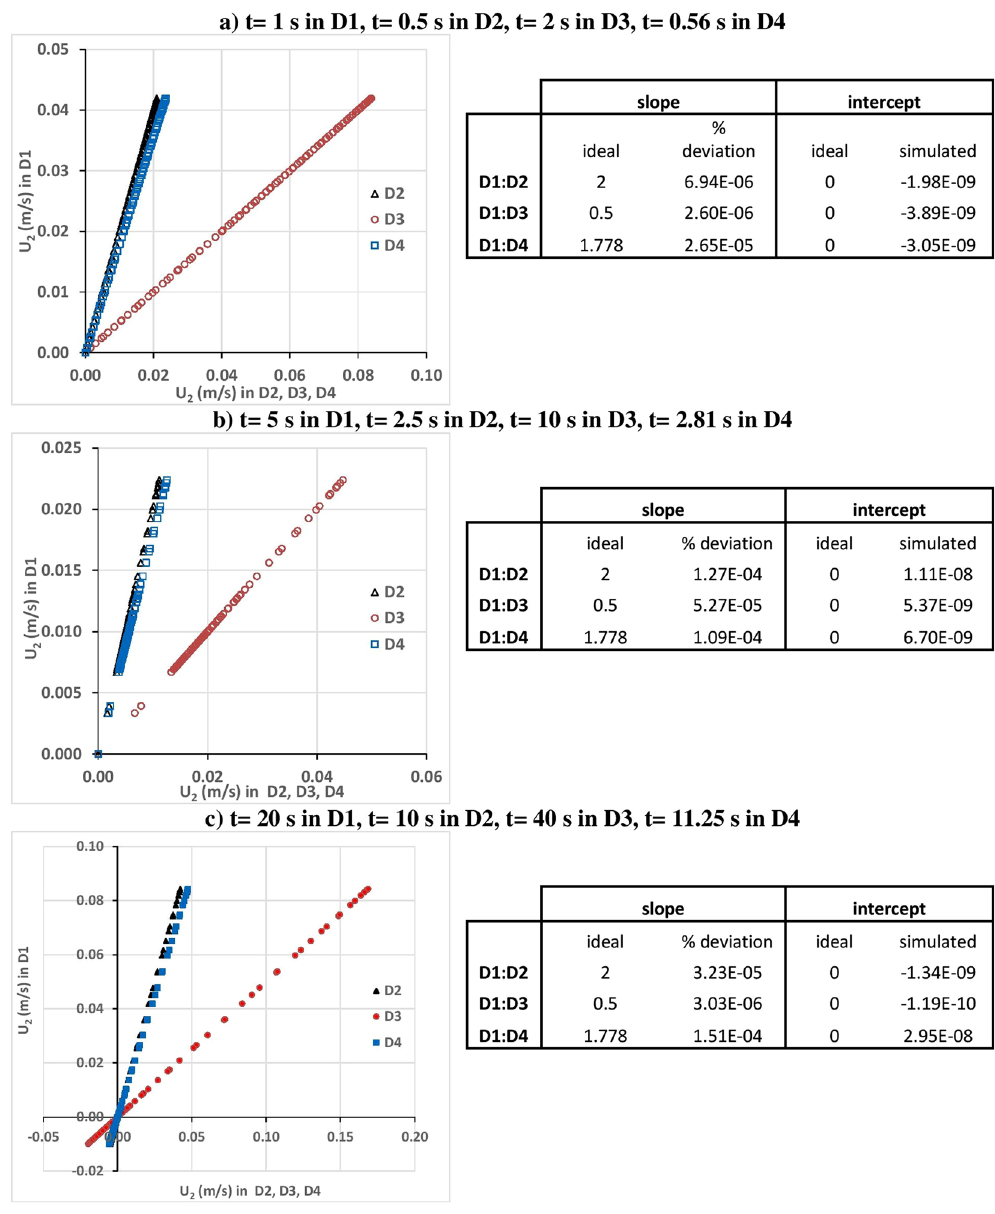
Figure 3. U 2 at simulation times ( a ) 1, ( b ) 5 and ( c ) 20 seconds along the intersection line of planes x = 0.05 m and z = 0.05 m planes (i.e., the centerline of the cube in x 2 direction) in domain 1 (D1) versus the corresponding velocities in domains 2, 3, and 4 (D2, D3, and D4). Simulation time of 1 s in D1 corresponds to 0.5 s in D2, 2 s in D3, and 0.56 s in D4. Simulation time of 5 s in D1 corresponds to 2.5 s in D2, 10 s in D3, and 2.81 s in D4. Simulation time of 20 s in D1 corresponds to 10 s in D2, 40 s in D3, and 11.25 s in